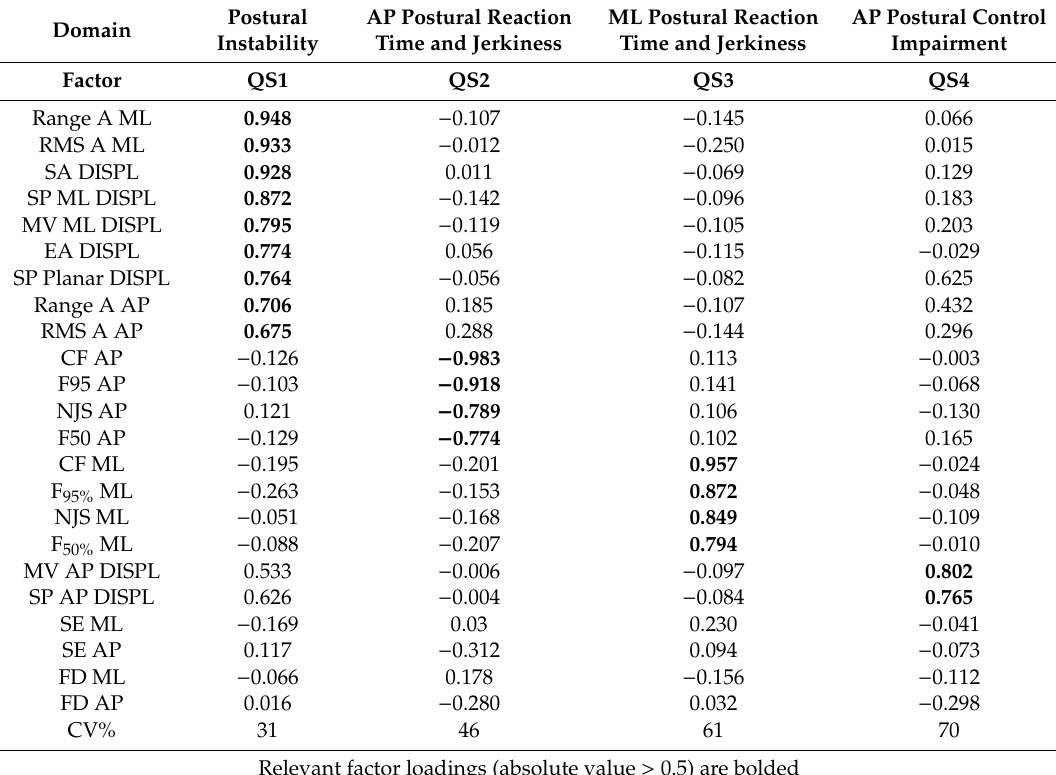
Table 5. QS factor model: factor loadings of the sensor-based measures, corresponding domains and Cumulative Variance (CV) (Varimax Rotation).